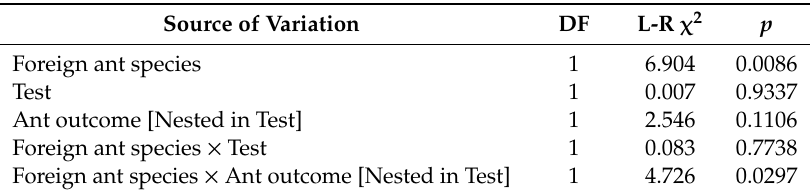
Figure 4. Survivorship of caterpillars of P. alcon over the course of the experiments under the different experimental treatments, according to “ant outcome” (see results), and in the nurse colonies over the same time period. The Myrmica species is that found with the caterpillars at the end of the experiment. Table 2. Results of analysis of survival over the 20 days of the tests using a generalized linear model with binomial errors. The replication unit for this analysis is the test colony (n = 40). The significance of changes in deviance associated with different terms in the model was assessed using Likelihood-ratio (L-R) χ 2 tests. Potential sources of variation in survivorship were: Foreign ant species—The introduced Myrmica species (the species that was not used in nurse colonies), either M. scabrinodis or M. sabuleti . The Test (“Vacant possession” or “Takeover”), and the Ant outcome, which was nested within Test, since only a single outcome was possible for the “Vacant possession” test (takeover by the foreign ant species), while two outcomes (continued tending by the original host ant species or takeover by the foreign ant